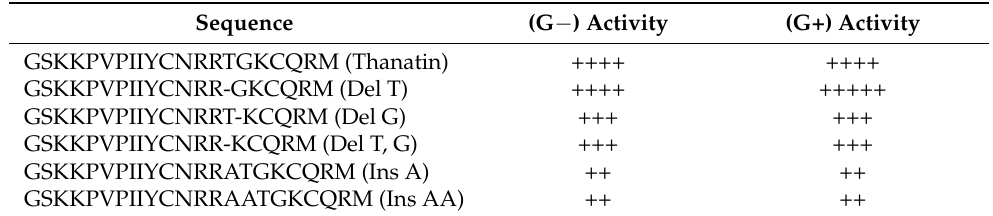
Table 3. Primary structures and antimicrobial activity of deletion and insertion variants of thanatin.